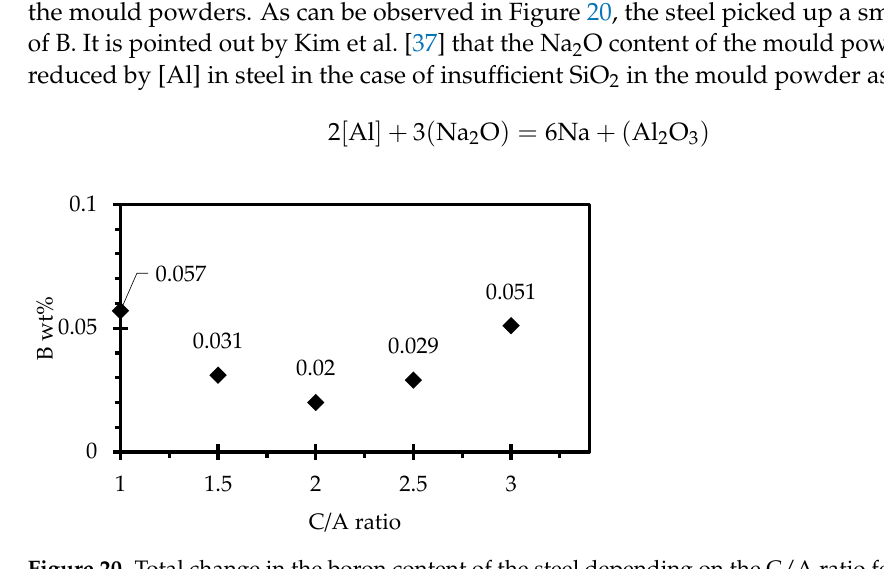
Figure 20. Total change in the boron content of the steel depending on the C/A ratio for the 20 min interaction time.